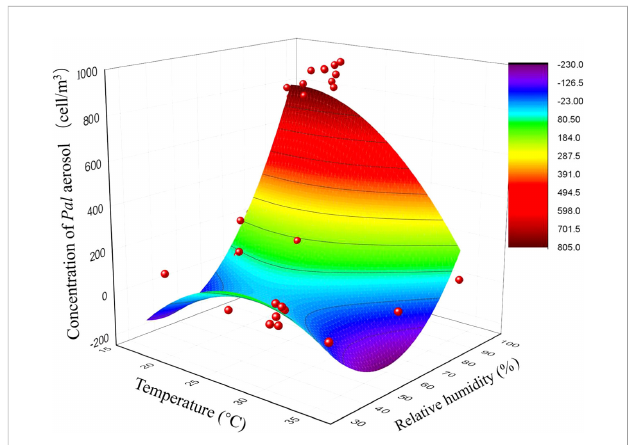
FIGURE 6 The 3D surface plot of the co-in fl uence of temperature and relative humidity (RH) on concentration levels of Pseudomonas amygdali pv. lachrymans ( Pal ) in aerosols in naturally infested cucumber greenhouses. Bioaerosol samples were collected from nine naturally infested greenhouses, which located in Tianjin City (n=2), Hebei (n=3) and Shandong (n=4) Provinces, from 2019 to 2021. The concentration of Pal in aerosols was detected by qPCR. Temperature and RH in greenhouses were obtained using a digital thermo-hygrometer. The co-in fl uence of temperature and RH on Pal aerosol concentration presented as a six-parameter model: Z = Z 0 + ax + by + cxy + dx 2 + fy 2 . In which, Z = Pal aerosols concentration, x = temperature, y = RH.